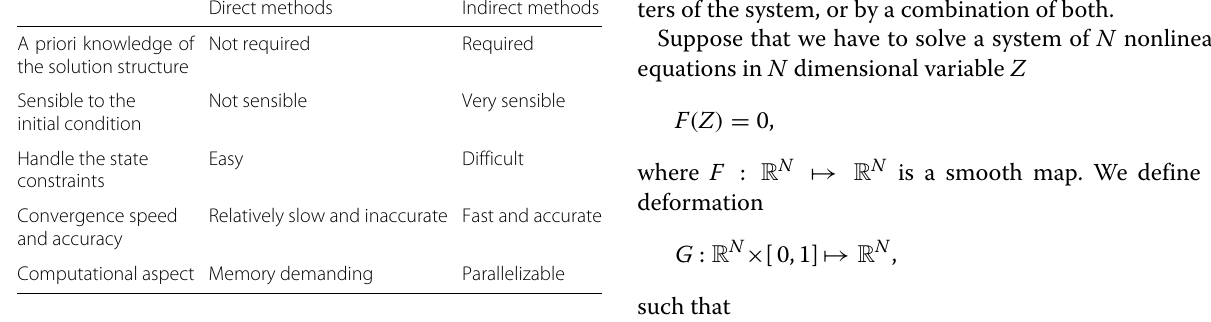
Table 1 Pros and cons for direct and indirect methods Direct methods Indirect